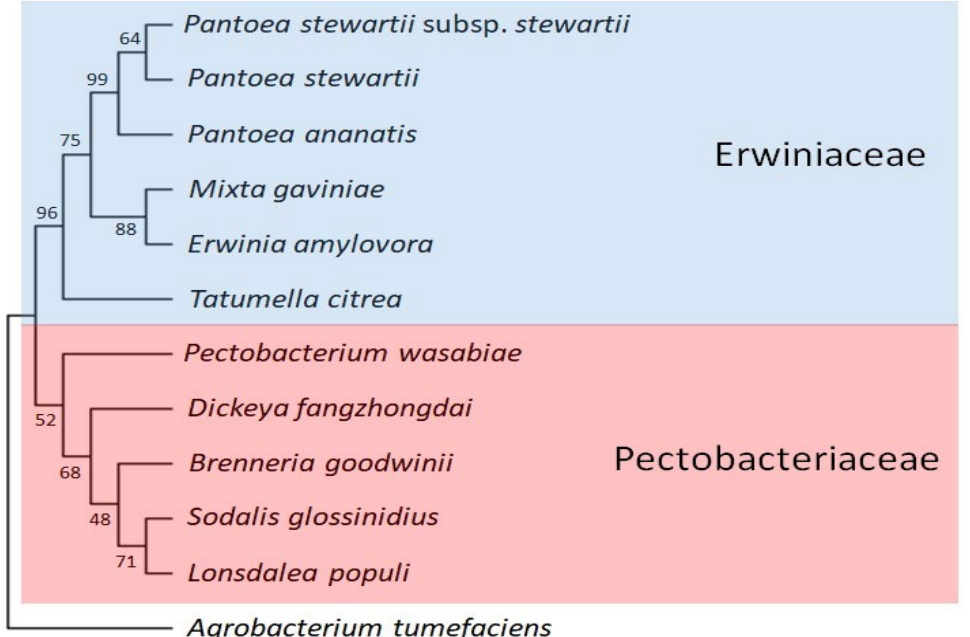
Figure 6. The phylogenomic tree depicted typical strains of Erwiniaceae and Pactobacteriaceae within the order Enterobacterales. The order is well-known as agriculture-harming phytopathogens, predominantly the genera Pantoea , Erwinia (Erwiniaceae), Pectobacterium, Dickeya, and Brenneria (Pectobacteriaceae). These clades include the species of the genera Mixta, Tatumella, Sodalis, and Lonsdalea . The causal agent of crown gall disease, Agrobacterium tumefaciens is an outgroup. The mechanisms driving these events are never adequately elucidated, and informa- tion on the regulatory network of bacterial peptide transporters involved in pathogenesis is limited. Figure 7 shows the key inducer for peptide transporter expression and the principal bacterial virulence-associated with peptide transporters